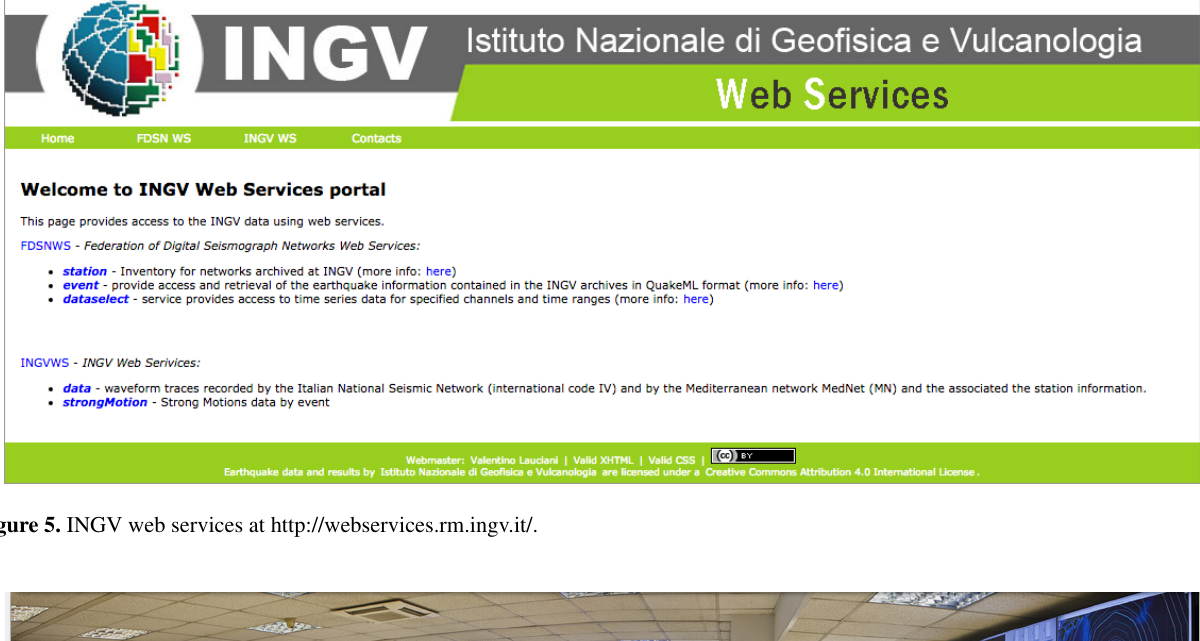
Figure 5. INGV web services at http://webservices.rm.ingv.it/.